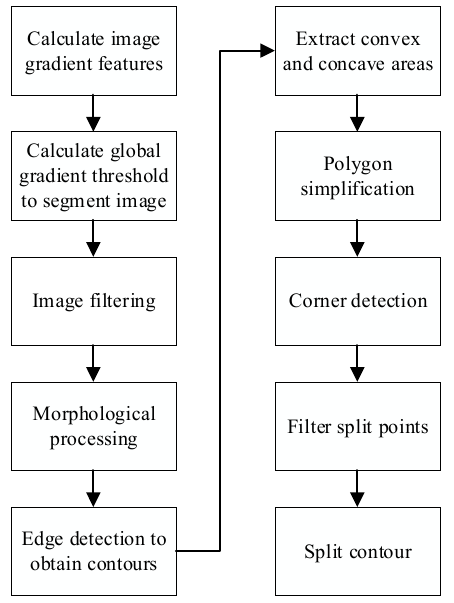
Figure 1. Flow chart of segmentation of Agaricus bisporus.